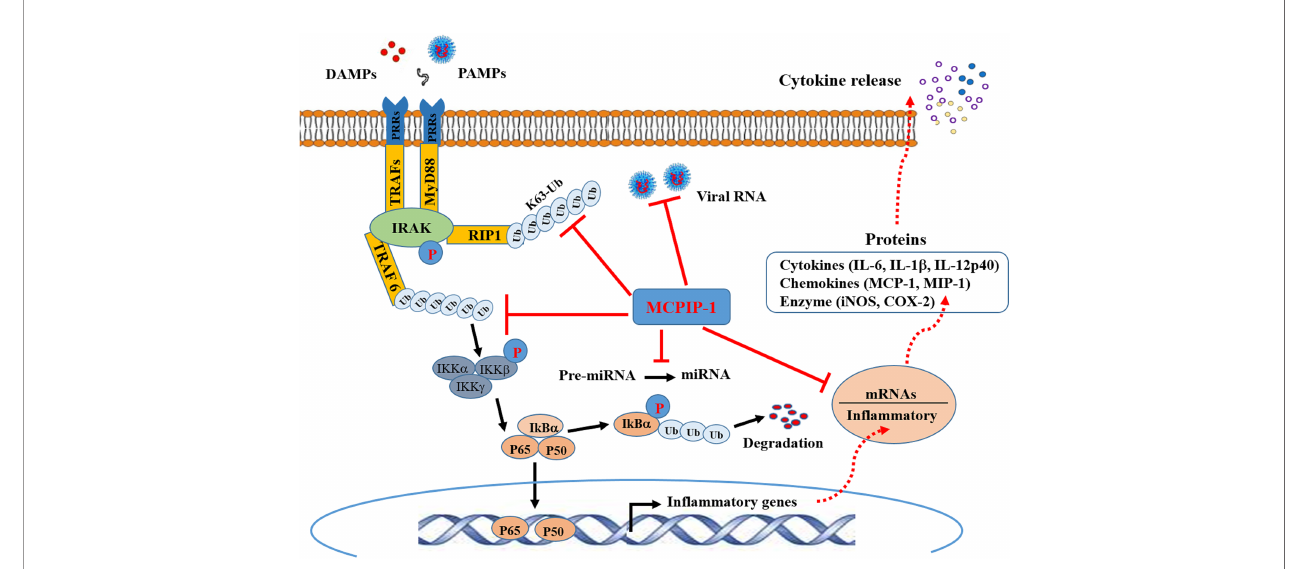
FIGURE 1 | Schematic representation of anti-in fl ammatory activity of MCPIP-1. Binding of molecules (DAMPs) derived from tissue damage or pathogens (PAMPs) to PRRs triggers interactions between the cytoplasmic adaptor proteins and the kinases IRAK. This engages the ubiquitin ligase TRAF6 to make polyubiquitin chains that activate the IKK complex, leading to phosphorylation and subsequent ubiquitination IKB a . This releases P50/p65 dimer for entry into the nucleus to cause transcriptional activation of NF k B-dependent genes encoding in fl ammatory cytokines. Ubiquitylation of RIP1, and potentially other components of the complex, recruits IKK g and TAK1 for NF k B and MAPK activation (not shown). MCPIP-1 hydrolyzes all of these K48- and K63-linked polyubiquitins to block NF k B activation. The RNase activity of MCPIP-1 also degrades viral RNA and some mRNAs encoding for in fl ammatory cytokines, leading to dampening of protein expression of